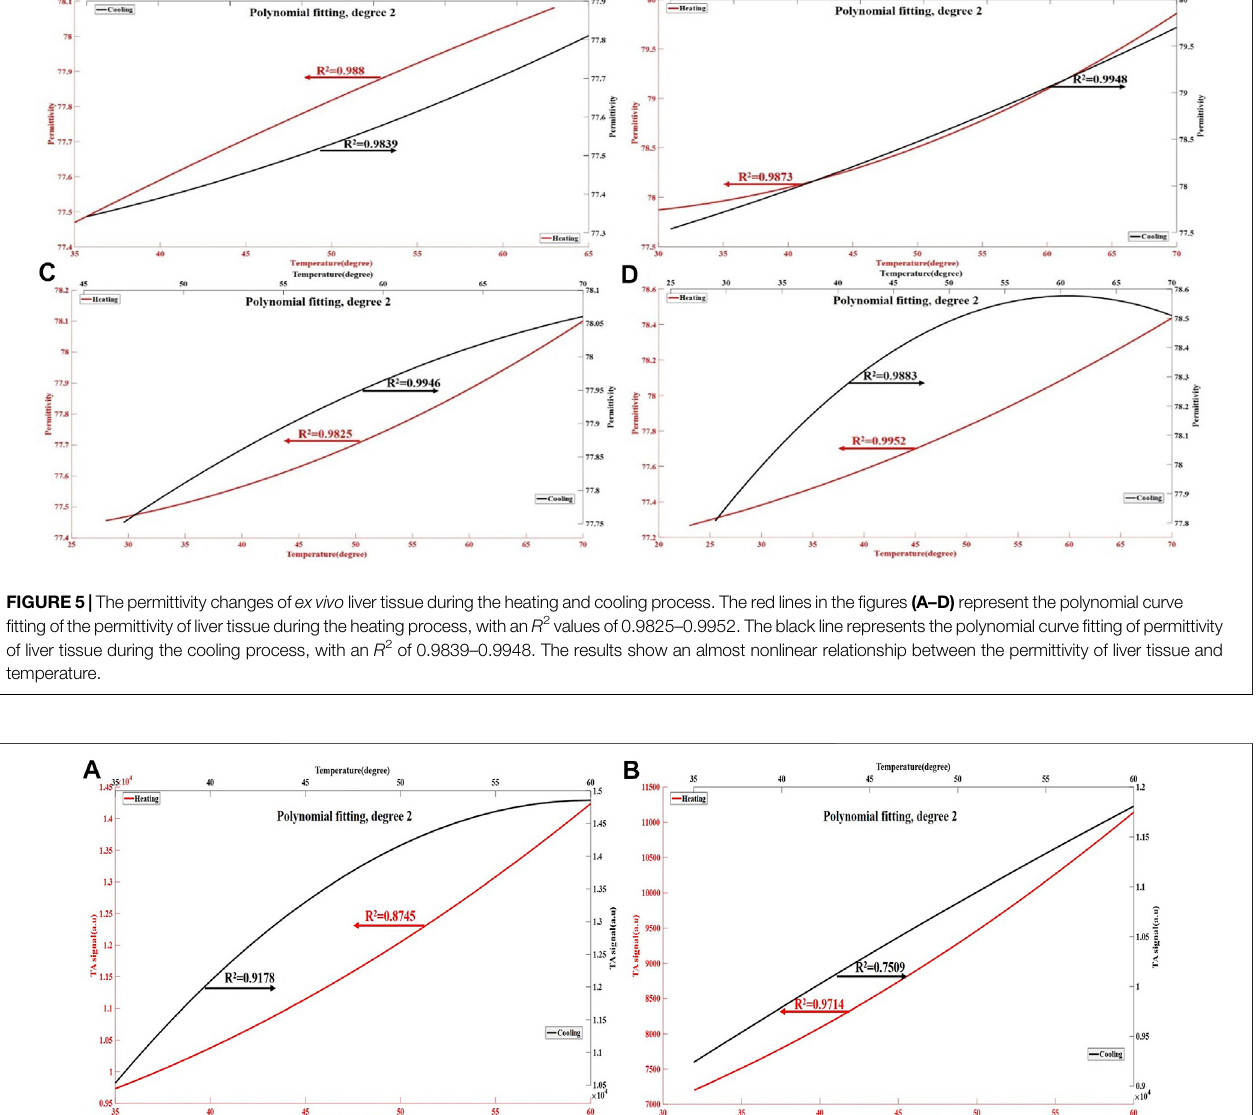
Frontiers in Physics |